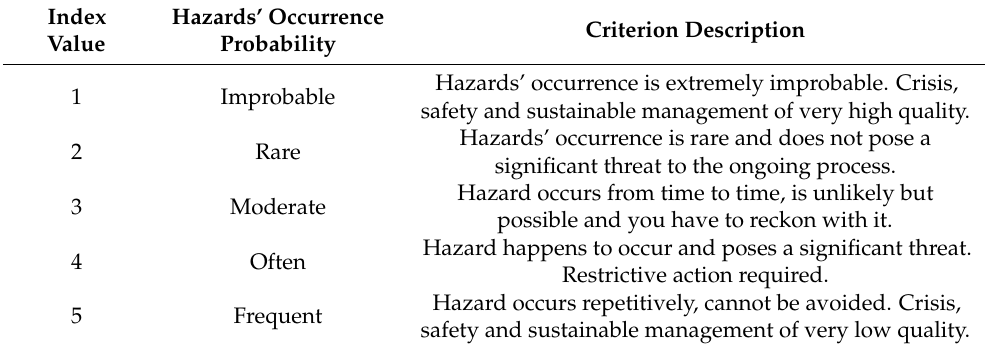
Table 1. Proposed classification table for safety risk probability index— P , own work based on